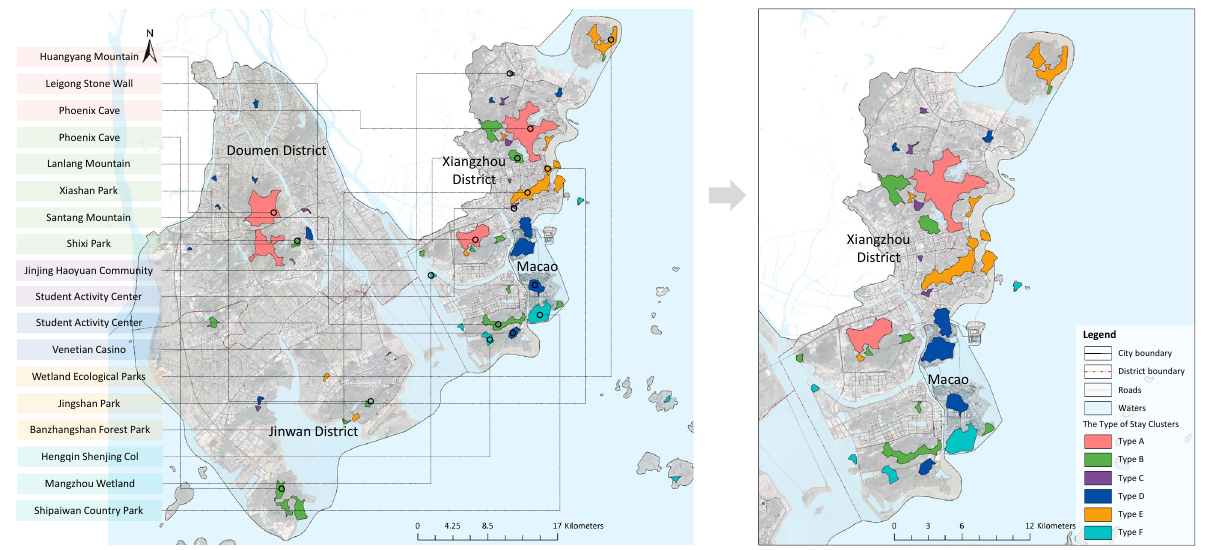
Figure 6. The results of cluster analysis.